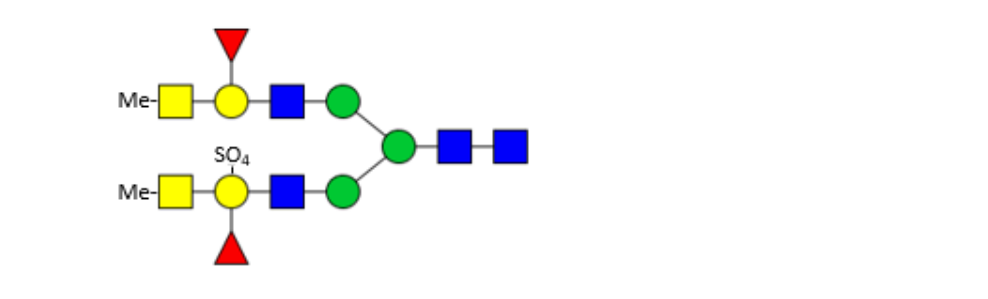
Figure 5. Example of a Crassostrea virginica glycan [74]; For the symbols key see Figure 1. In addition, different nematodes use snails, for example Achatina fulica , as intermedi- ate hosts in their life cycles, but no detailed information on glycan involvement is given [75].